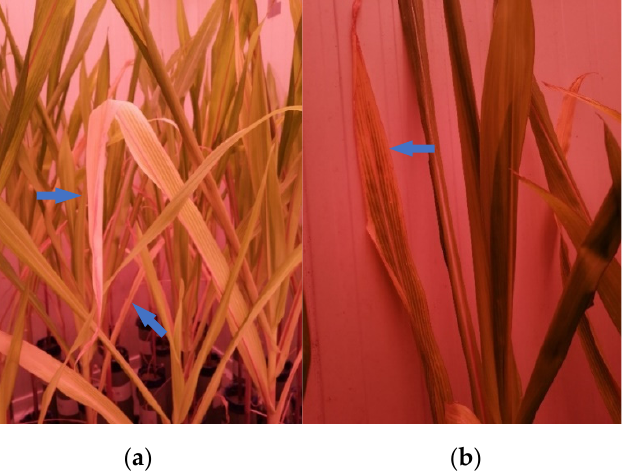
Figure 1. Images of maize leaves photographed on day 70. The blue arrows show the yellow and dried leaves. ( a ) old leaves turned pale or yellowish-green; ( b ) an inverted “V” or spear-shaped discoloration starting at the tip of the leaf.